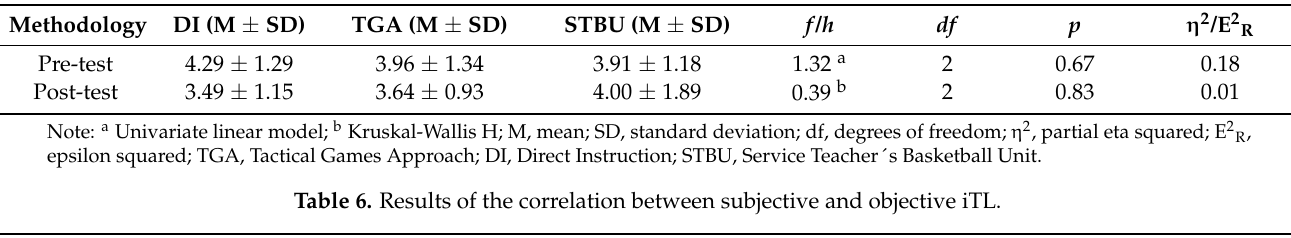
Table 5. Results of the RPE scale in the assessment tests according to methodology.